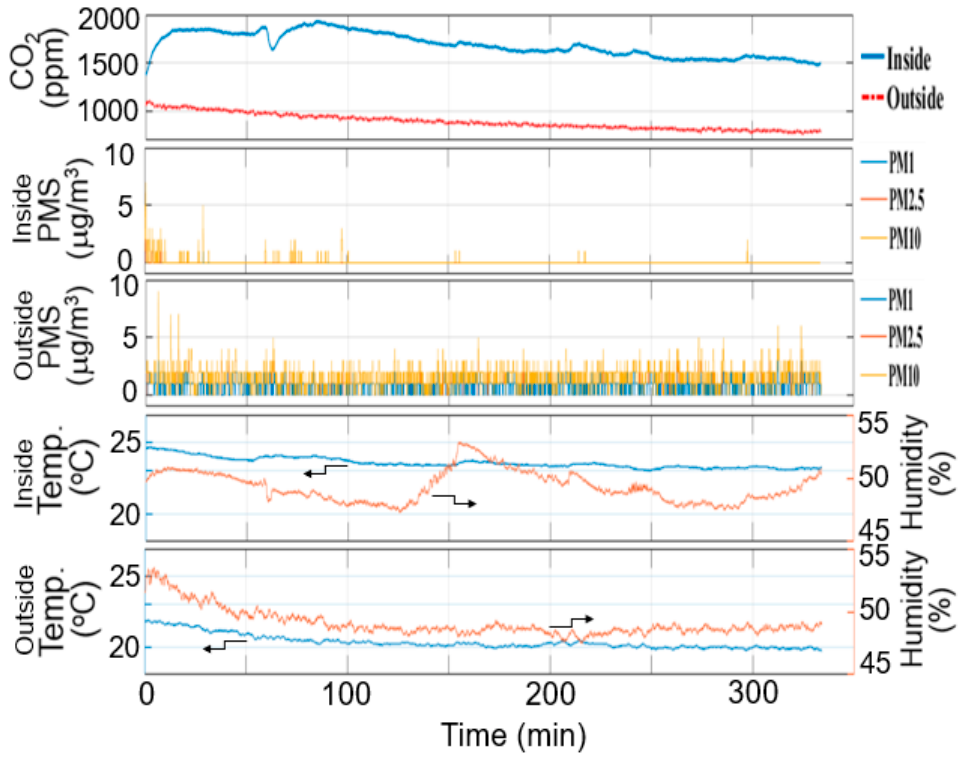
Figure 4. The air quality parameters in the spaces outside and inside the CAQLEA simultaneously measured through two IoT sensor modules.